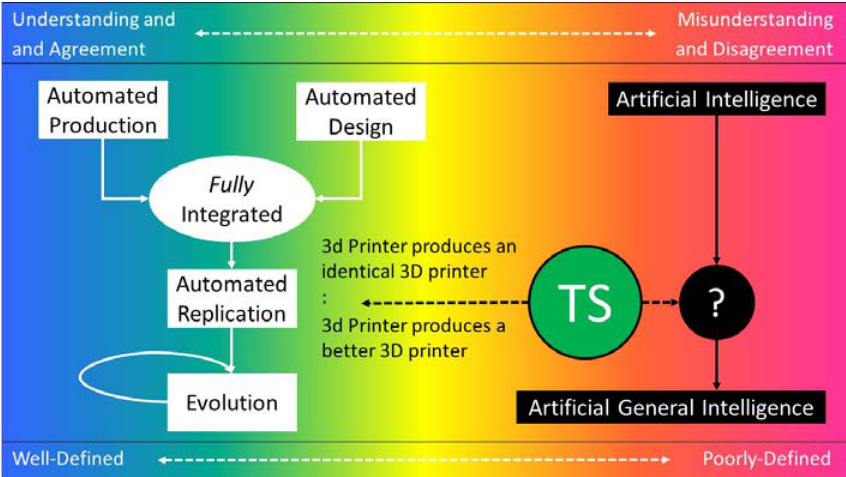
Figure 1. Combined (but simplified) models of the technological singularity. TS, Technological Singularity.